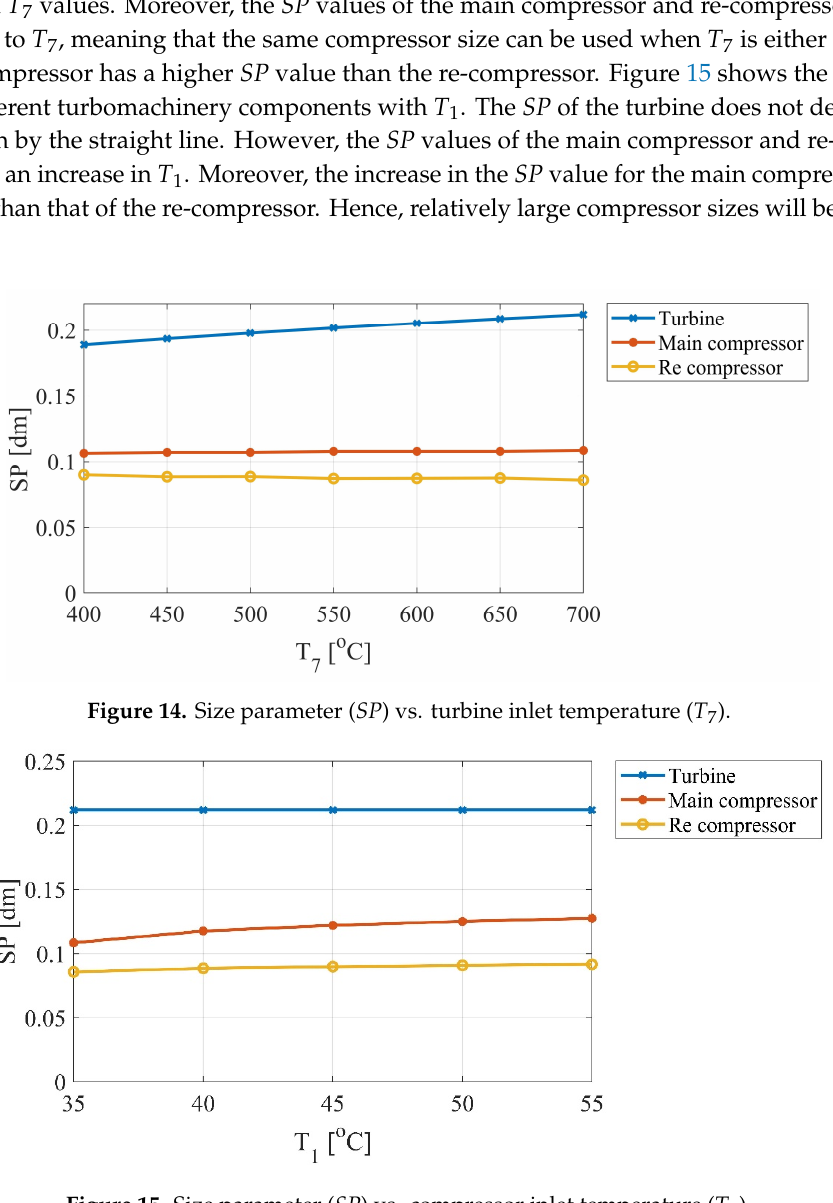
Total ) vs. split mass fraction ( x ) at T 7